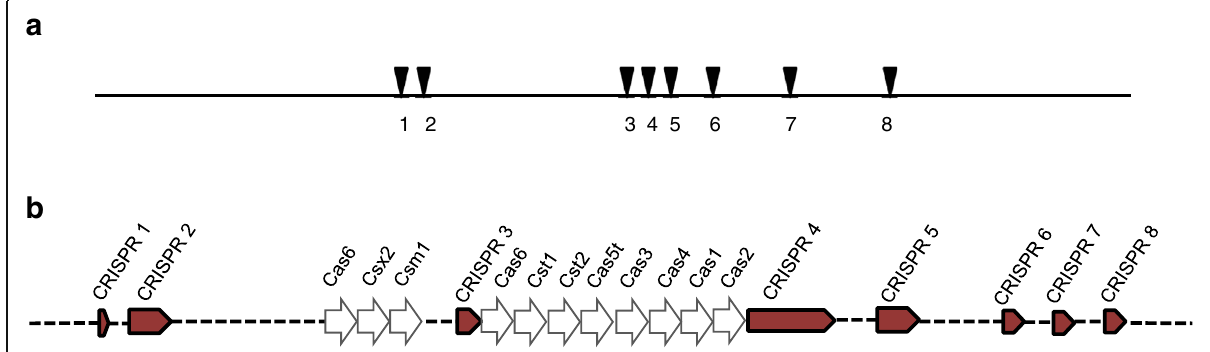
Fig. 5 Diagrammatic representation of CRISPR/Cas systems in T. sp. strain RQ7. a Positions of the 8 regions of CRISPR arrays; drawn in scale using